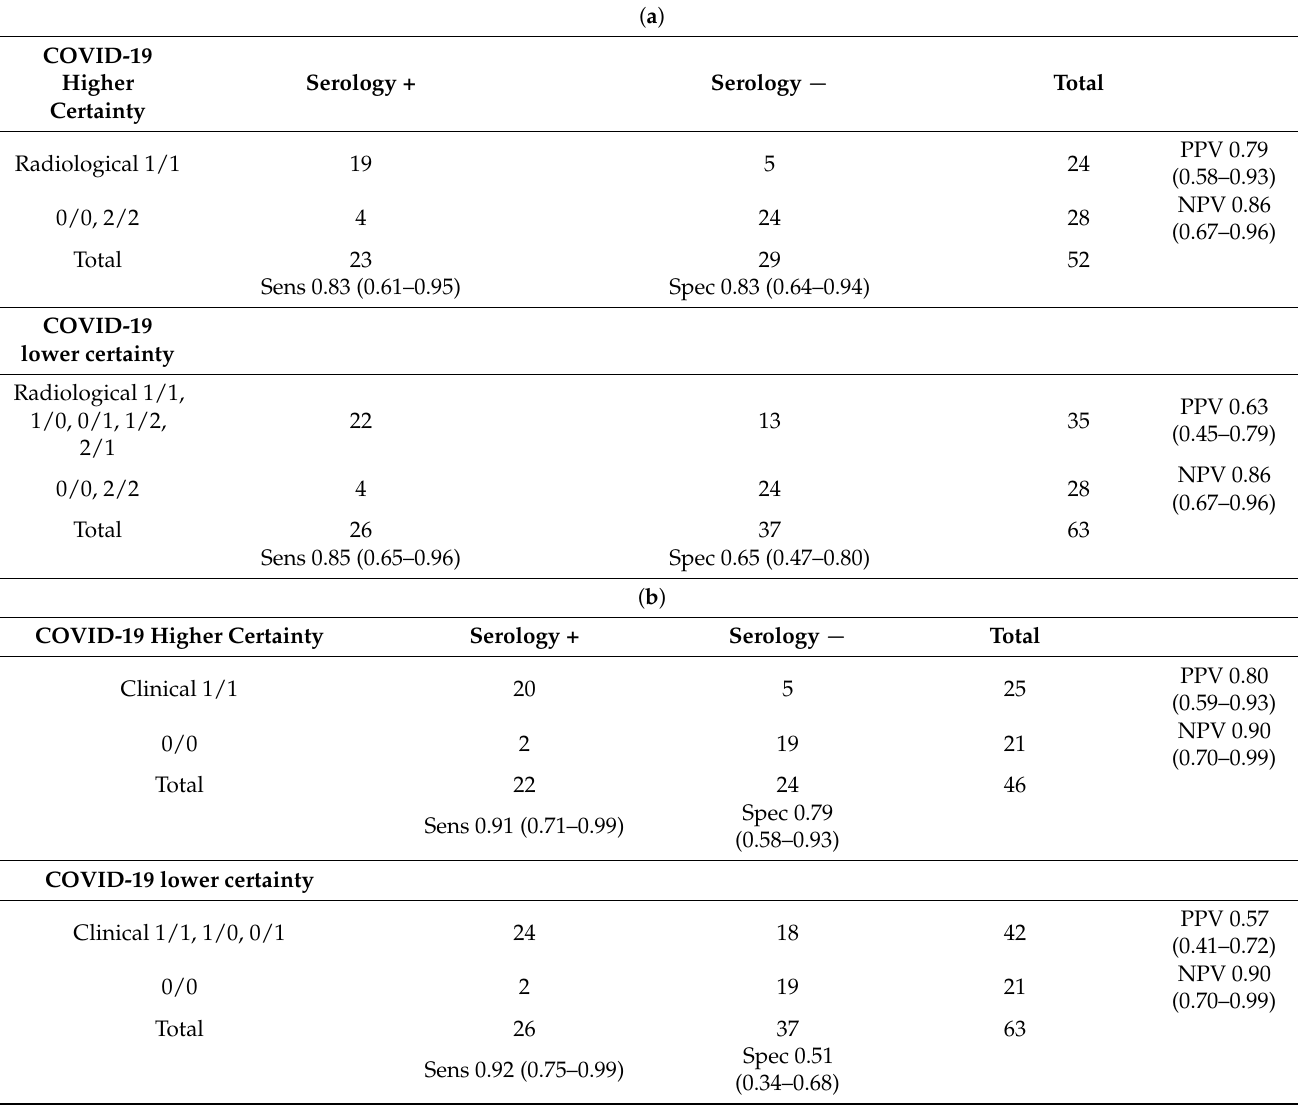
Table 2. Accuracy of radiological ( a ) and clinical diagnosis ( b ) vs. serology ( a